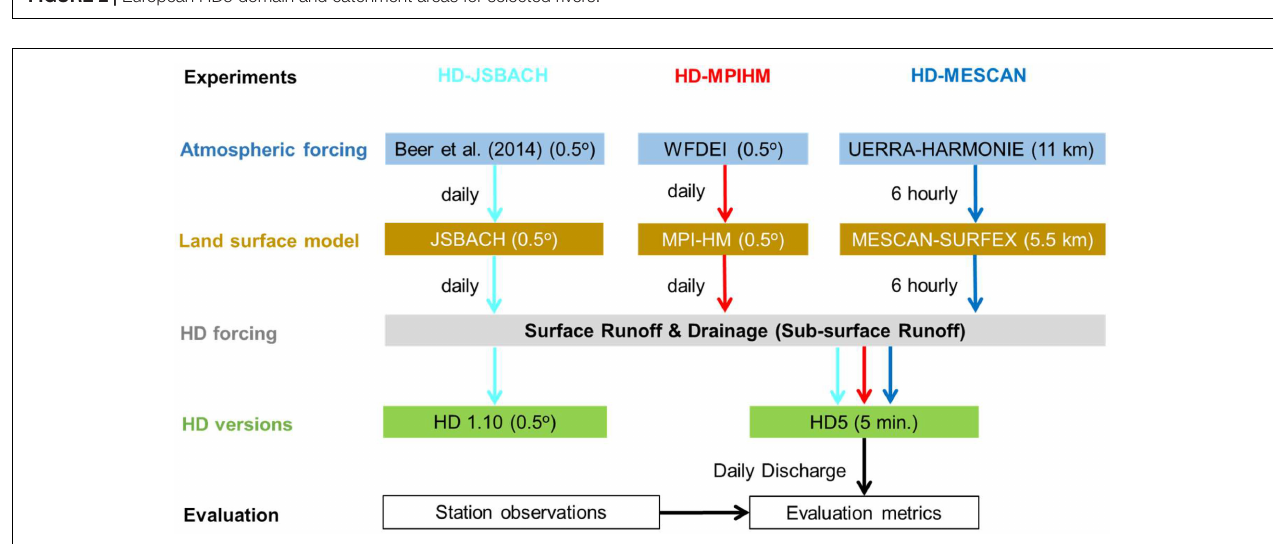
FIGURE 2 | European HD5 domain and catchment areas for selected rivers.